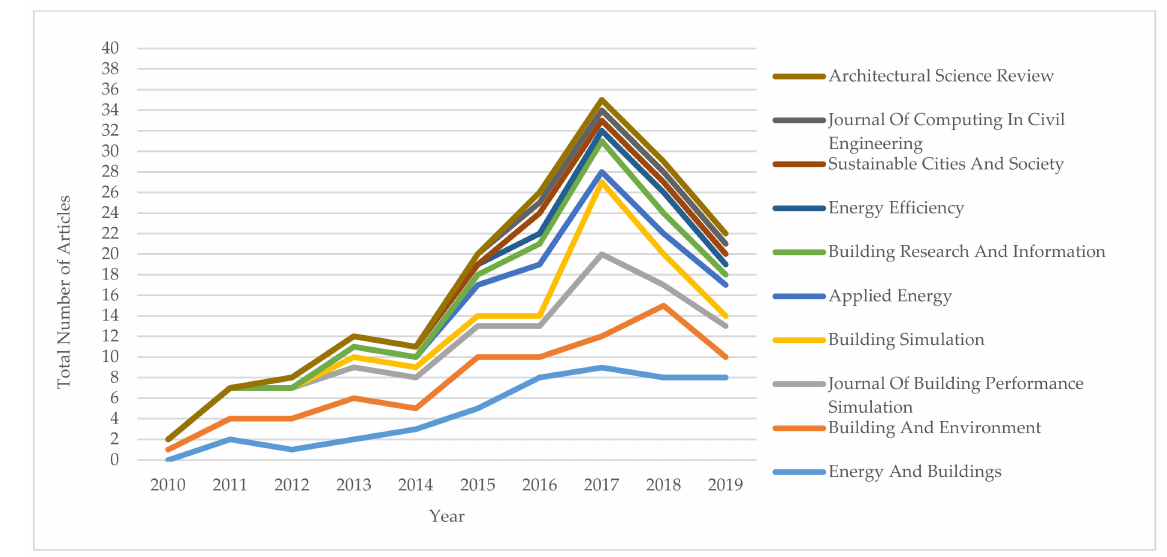
Figure 4. The trend in keywords “Occupant Behavior”, “Modeling”, and “Building”.